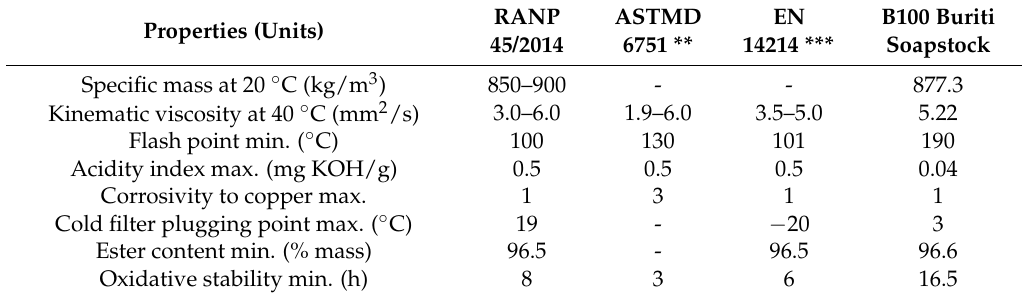
RANP ASTMD EN B100 Buriti 45/2014 6751 ** 14214 *** Soapstock